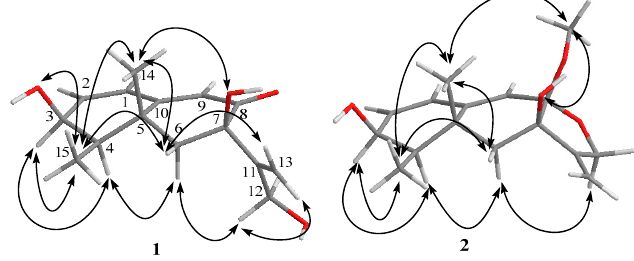
Figure 3. Key NOE correlations of 1 and 2 .